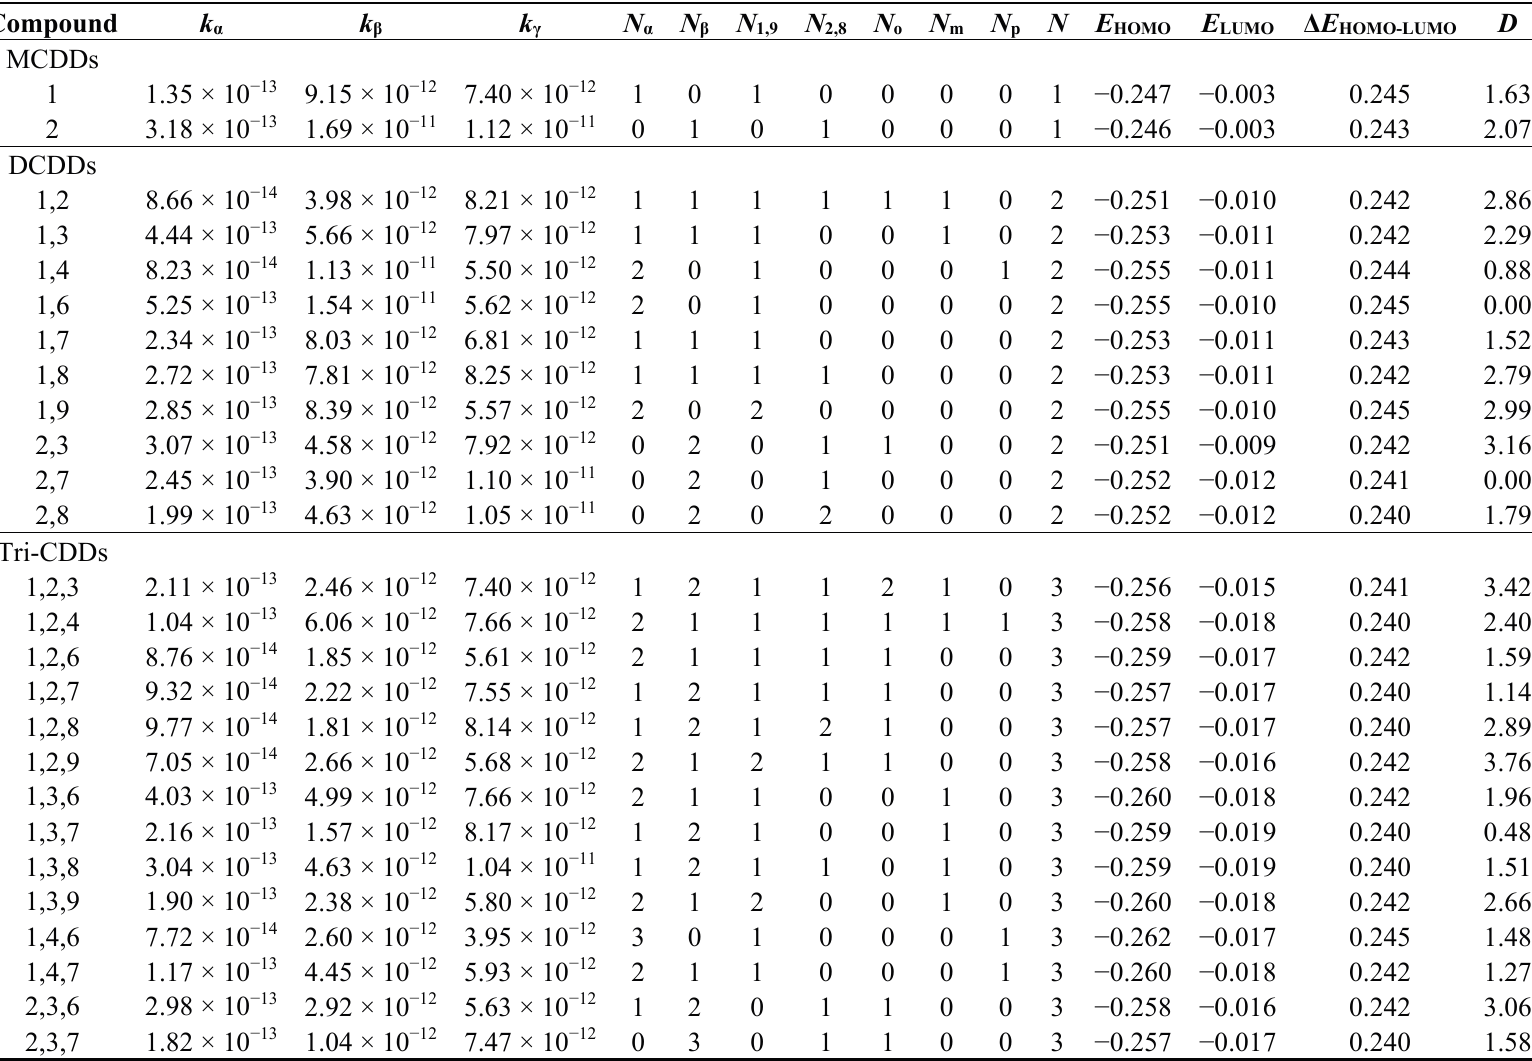
Table 1. The rate constants ( k α , k β , k γ ) of MCDDs, DCDDs and Tri-CDDs with